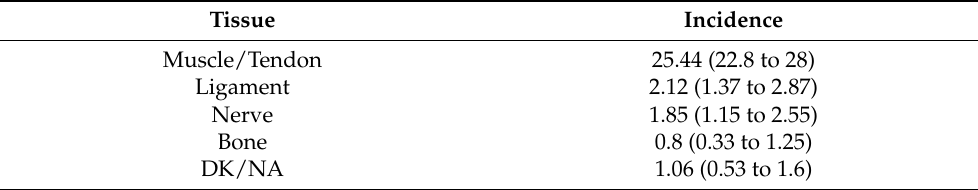
Table 3. Injury incidence per